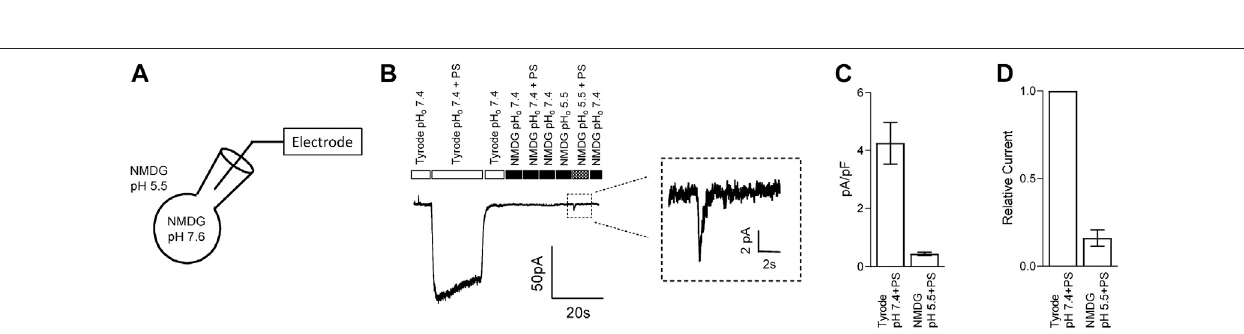
FIGURE5| TRPM3ispotentiallypermeabletoprotons. (A) Schematicshowingtheprotonspermeationrecordingcondition,whereallintracellularandextracellular ionswerereplacedbyNMDGandglutamicacid,respectively,exceptforprotons.50 µM PSwasappliedwhileholdinghTRPM3-GFPtransfectedHEKcellsat − 100 mV. (B) Inward currentswereelicitedbythePSapplication.NoPSactivated current undertheNMDG solutionatpH o 7.40, while loweringdown thepH o to5.50 generateda smalland transient inward current. Insertpanel shows theinwardcurrent recorded duringNMDG-PS (pH5.5) application. (C) Mean current amplitude in response to PS at the indicated conditions (mean ± SEM, n (cid:2) 8 cells). (D) Relative current amplitude in response to PS, comparing with Tyrode (pH o 7.4) solution response of the same cell (mean ± SEM, n (cid:2) 8